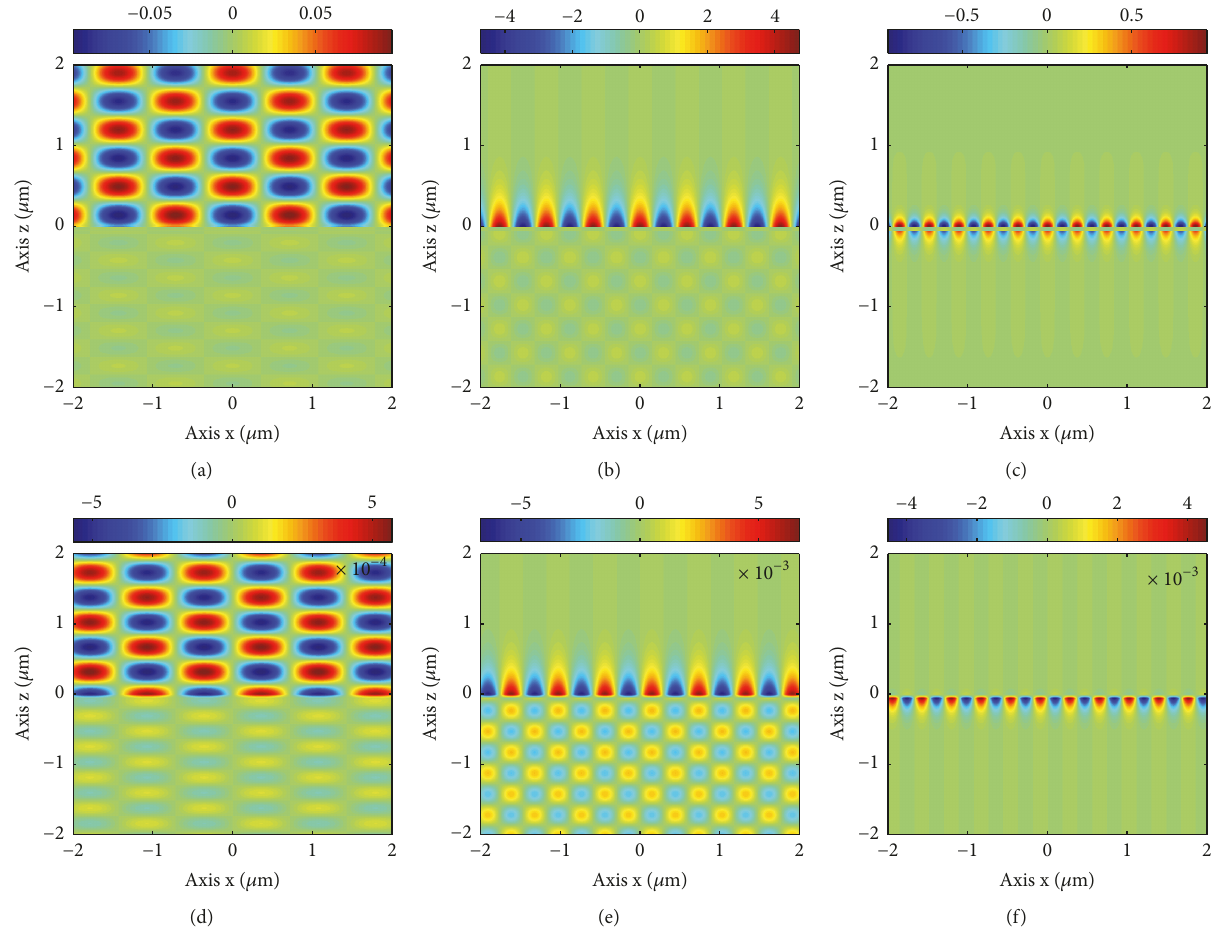
Figure 15: 𝐸 𝑧 and 𝐻 𝑦 in the 𝑥𝑧 plane, at 𝑦 = 0 , with Δ 𝑐 = 10𝜇𝑚 . Re {𝐸 𝑧 } for the term 𝑛 = 0 and (a) 𝑚 = 7 , (b) 𝑚 = 𝑚 𝑆𝑃𝑃1 = 17 , and (c) 𝑚 = 𝑚 = 27 ; Re {𝐻 } for the term 𝑛 = 0 and (d) 𝑚 = 7 , (e) 𝑚 = 𝑚 𝑆𝑃𝑃2 𝑦 = 50𝑛𝑚 , ℎ = 20𝑛𝑚 , 𝜃 󸀠 = 𝜙 󸀠 = 0 ∘ , and 𝜆 = 632.8𝑛𝑚 . 𝛿 𝑔